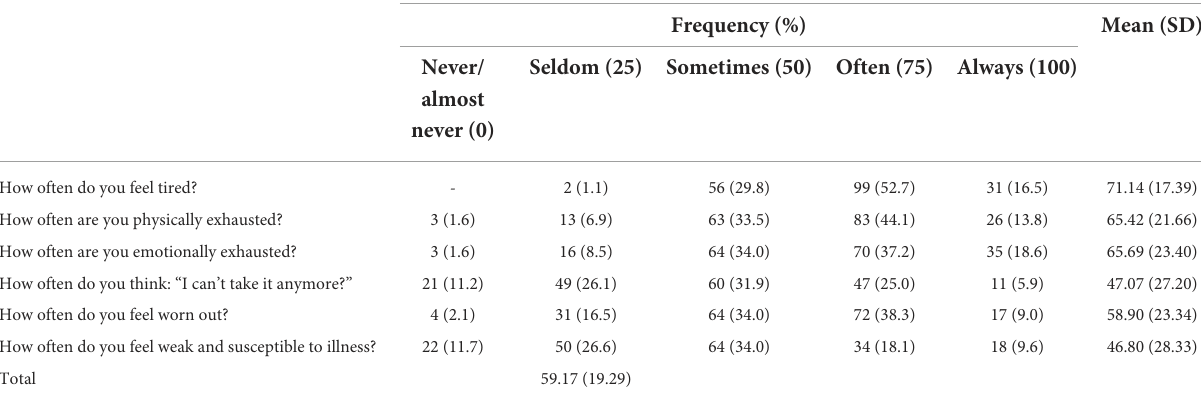
TABLE 2A Frequency distribution, mean and SD of the personal burnout scale.